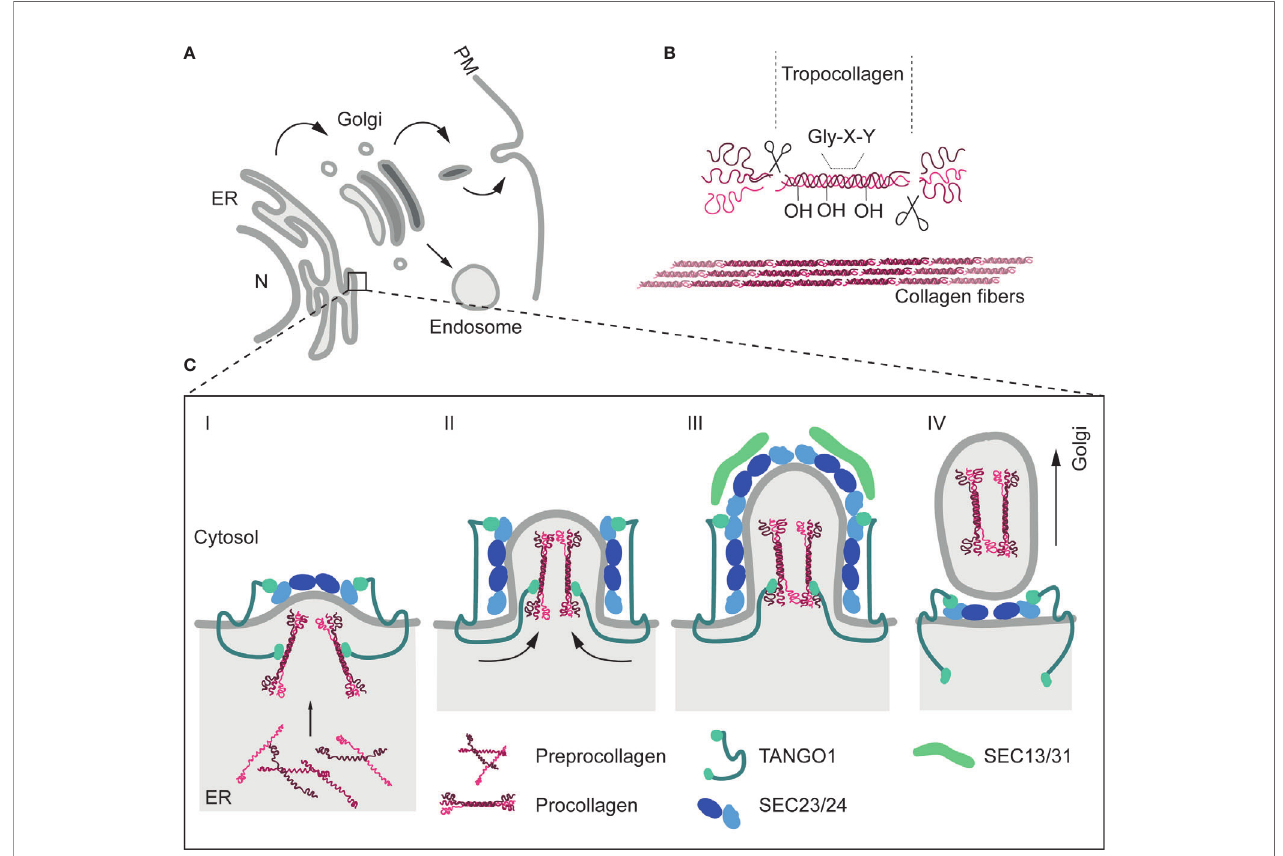
FIGURE 1 | The secretory pathway and collagen secretion. (A) Schematic representation of cell secretion routes. The ER constitutes the main protein factory in the cell. ER-associated ribosomes translate proteins that can be subsequently inserted onto the membrane, or released into the ER lumen. After translation, several modi fi cations can be added to proteins bydifferent enzymatic activities. Proteins are then transported to the Golgi apparatus, mainly through the COPII-dependent pathway. Within the Golgi, further modi fi cations are carried out. Finally, proteins will be sorted into vesicles and transported to their fi nal destination, including the plasma membrane (PM) (receptors, adhesion proteins and extracellular proteins) or endosomes. (B) Collagens are initially secreted as procollagens. Once in the extracellular space, terminal peptides are cleaved by the procollagen peptidase to form tropocollagen. Finally, collagen fi brils are assembled via covalent cross-linking by lysyl oxidases, which link hydroxylysine and lysine residues. Multiple collagen fi brils assemble into collagen fi bers. (C) In addition to COPII machinery, other regulators are necessary for the proper export of procollagen from the ER. TANGO1 participates in the sorting of procollagen in vesicles through a direct binding through Hsp47 in the lumen of the ER. Preprocollagen peptides are synthesised and assembled in the lumen of the ER. Once procollagens are formed, TANGO1, previously recruited trough the interaction to Sec23 (Sec23/24 complex), position the collagen fi brils in the budding vesicle (Stage I). Later, as the vesicle grow, TANGO1 pushes procollagen molecules towards the lumenal face of the ER (Stage II). In stage III, ER vesicles are big enough to accommodate collagens. TANGO1 separates its SH3-like domain from Hsp47/collagens. This is the followed by the release of TANGO1 from Sec23 and the recruitment of Sec13/31 to the ER membrane. Finally, in stage IV, fi ssion of the collagen-containing vesicles is undertaken and TANGO1 return to interact with the Sec23/24 complex